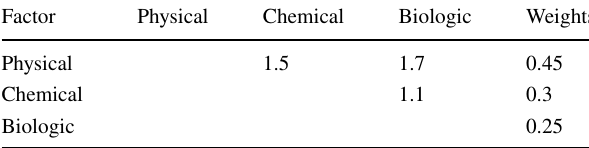
Table 2 Weights of the water quality factor assigned by AHP Factor